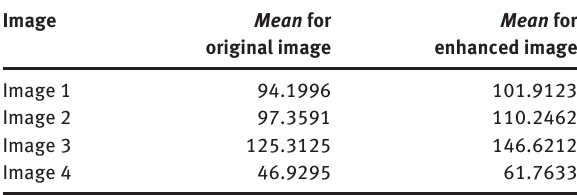
Table 4. Results for Mean.